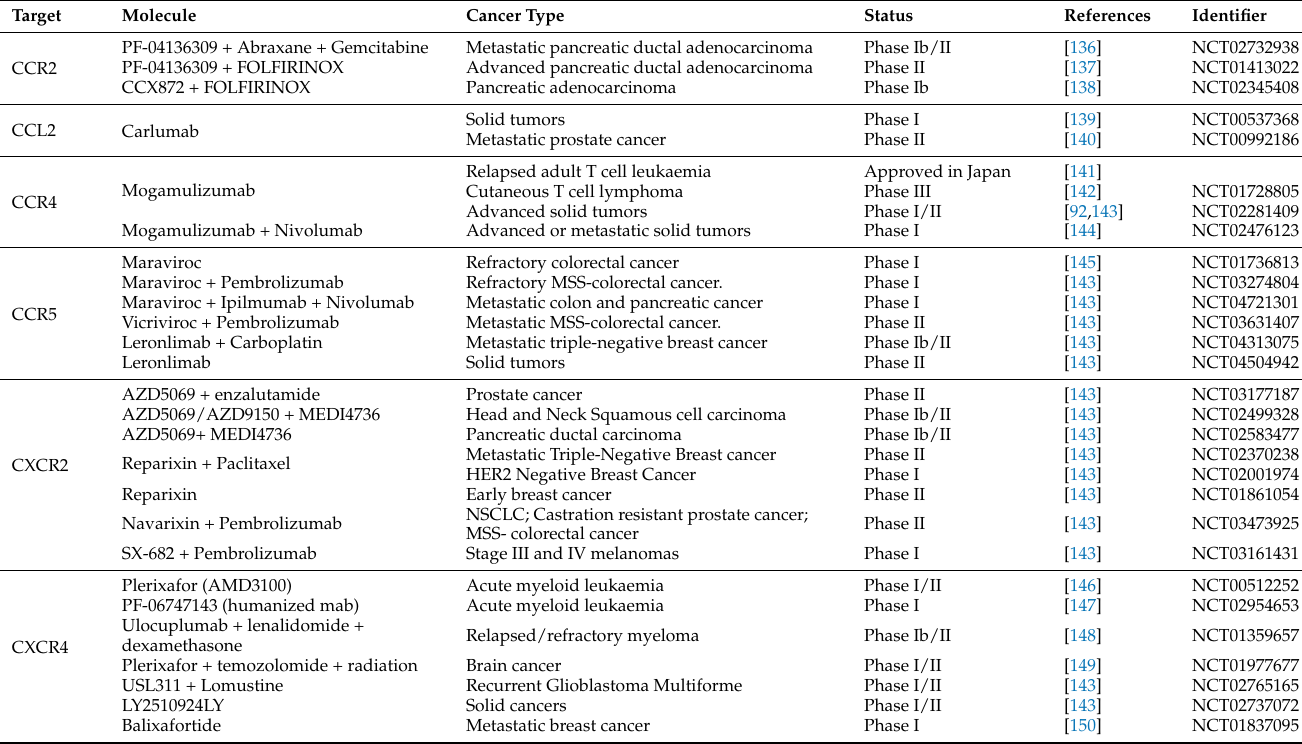
Table 3. Clinical trials involving chemokine inhibitors for cancer